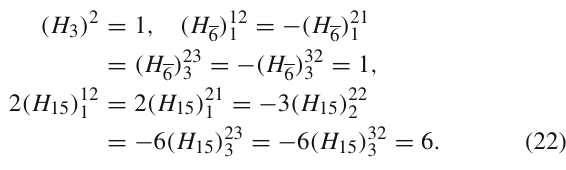
Table 1 Amplitudes for tetraquark T three mesons for the transition b → c (cid:14) − ¯ ν